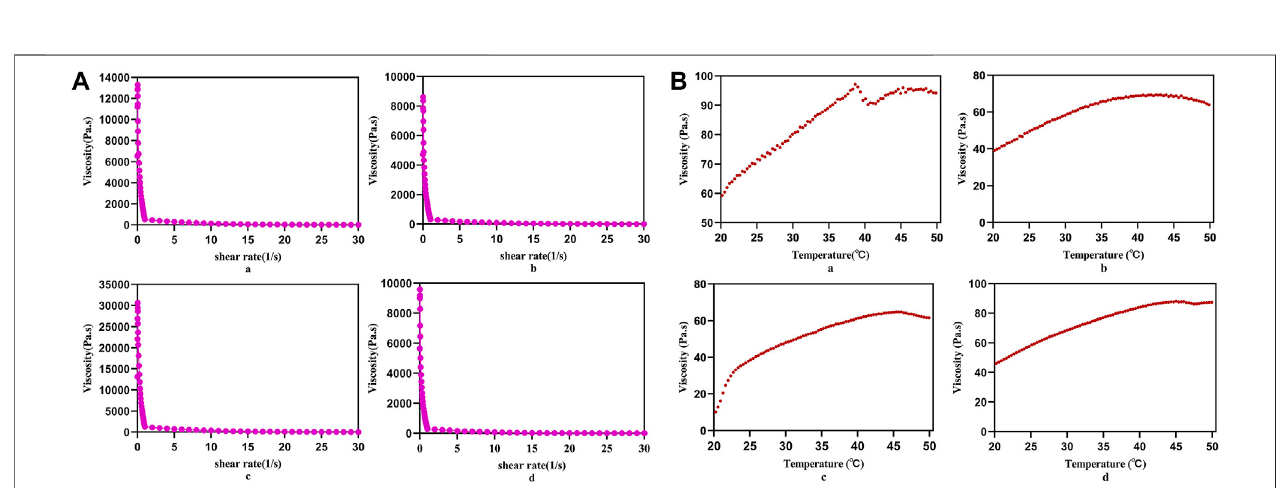
FIGURE 2 | (A) Static shear rate sweep test and (B) temperature sweep test of a) PLC3, b) PLC3-1, c) PLC3-2, and d) PLC3-3.